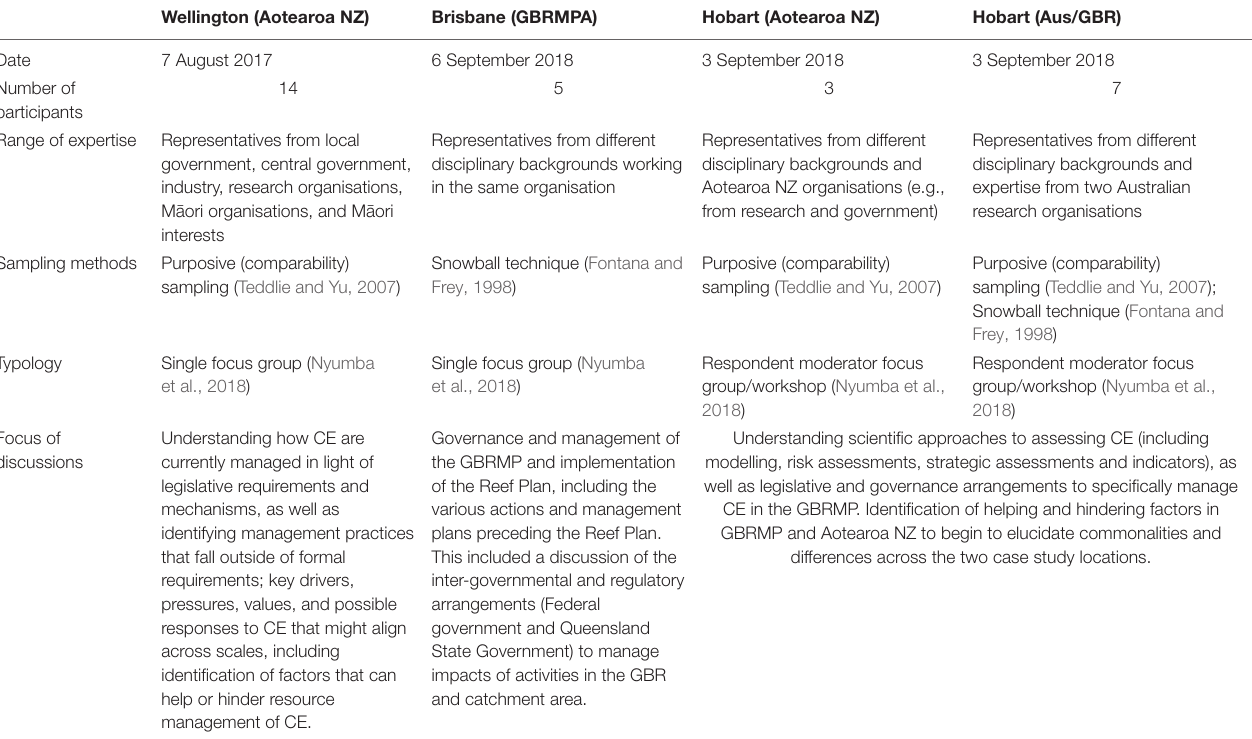
TABLE 2 | Summary of workshop and focus group